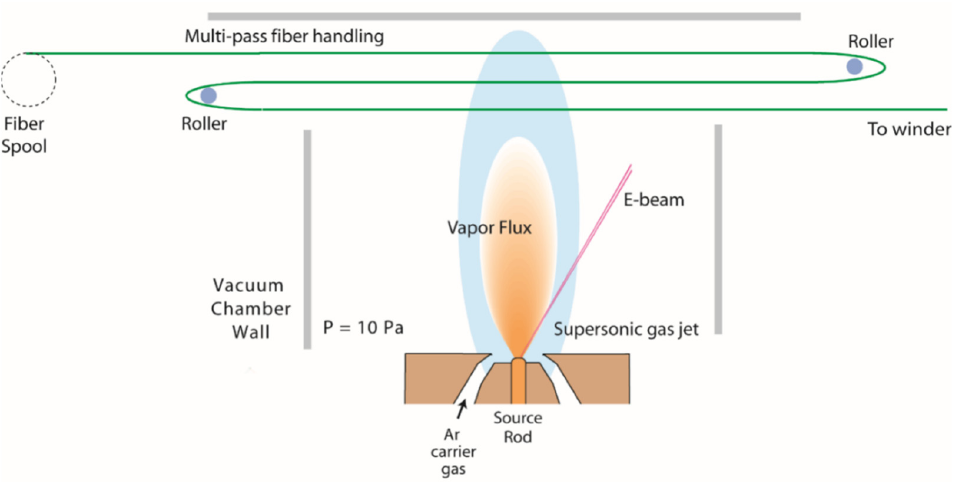
Figure 1. Schematic illustration of the Directed Vapor Deposition (DVD) system having a multi ‐ pass yarn handling yarn handling system.